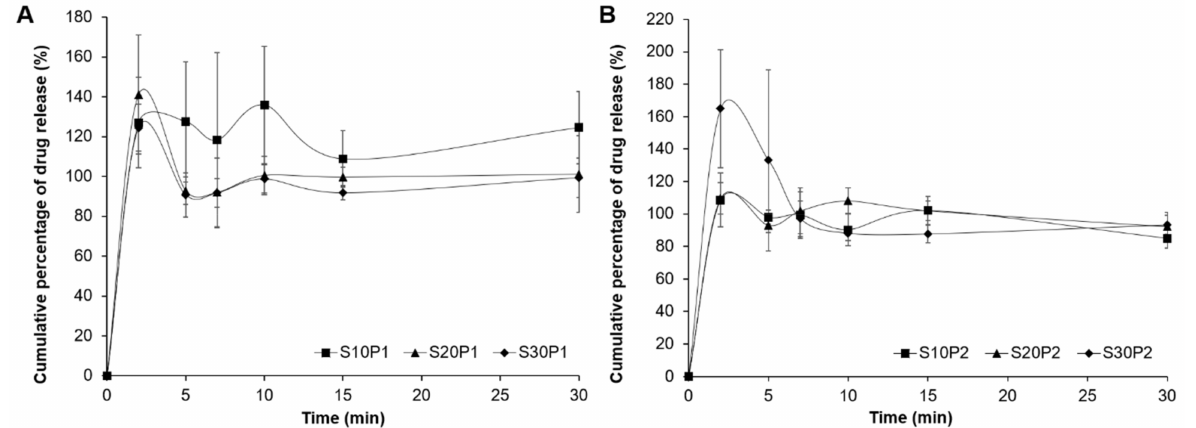
Figure 4. Drug dissolution profiles of rice starch films containing ( A ) 1 and ( B ) 2% w / w of paracetamol (PCM) with different concentrations of sorbitol (n = 3, mean ±